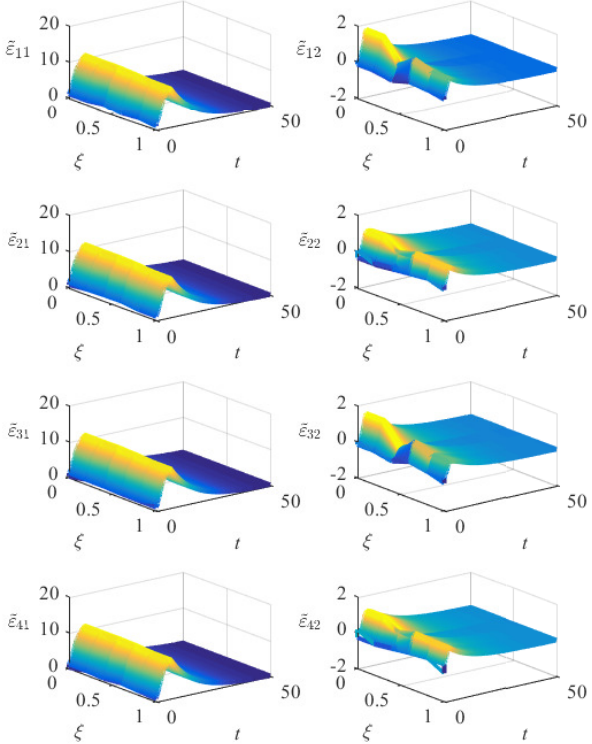
Figure 6. ˜ ε i ( ξ , t ) with the control gains d = 2.1 and k = 0.1 in Example 2. From another point of view, d = 1.9 and k = 0 do not satisfy (28). It can be seen in Figures 7 and 8 that the leader-following PDE-ODEMAS cannot achieve consensus with control gains d = 0.49 and k = 0 .